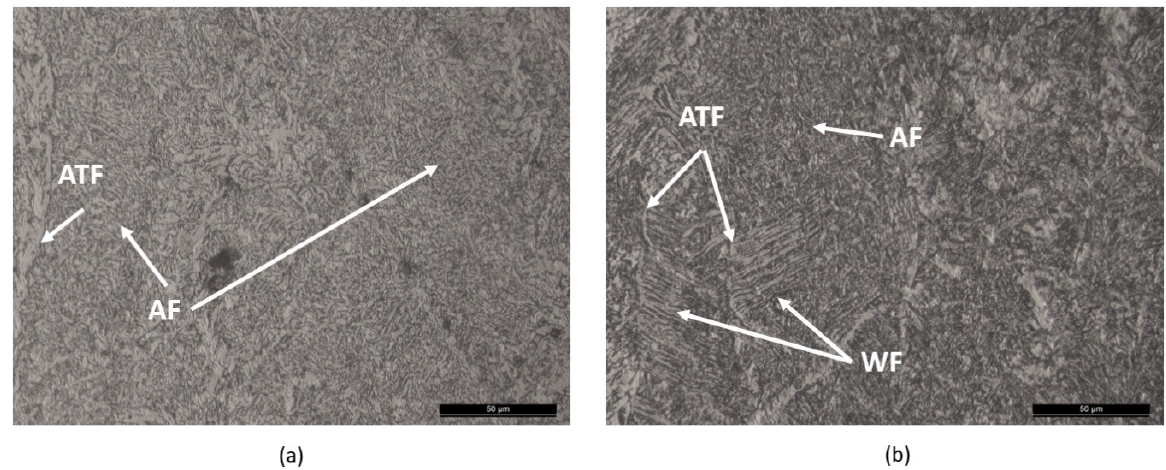
Figure 7. Micrographs of high heat input specimens produced from CMT ( a ) and MIG ( b ) processes ATF = allotriomorphic.